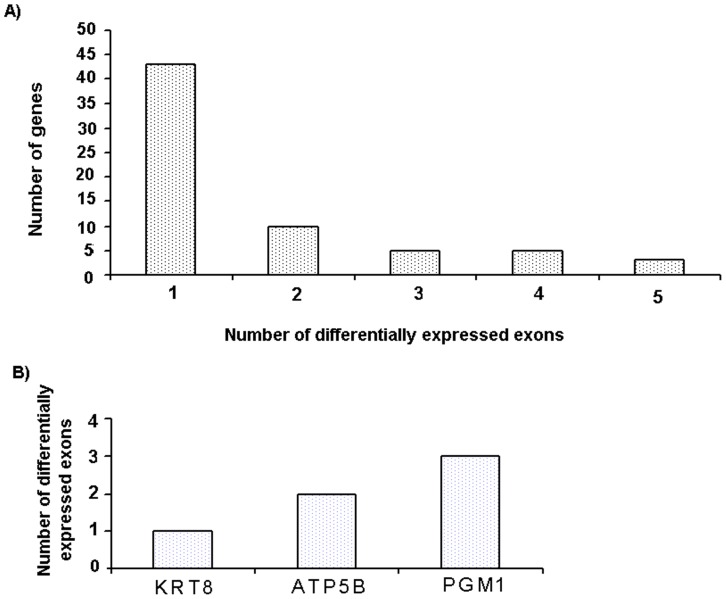
Distribution of the number of alternate splicing.The distribution of the number of alternate splicing the DEGs (A); number of alternate splicing in the selected genes (B).